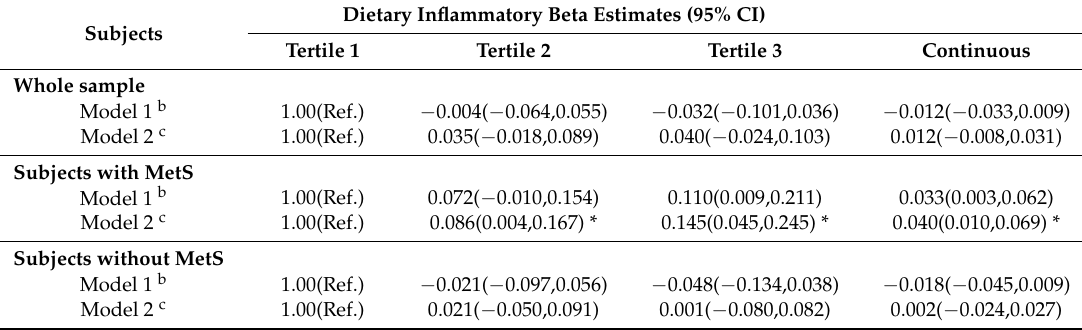
Table 5. Association between the DII and CRP a